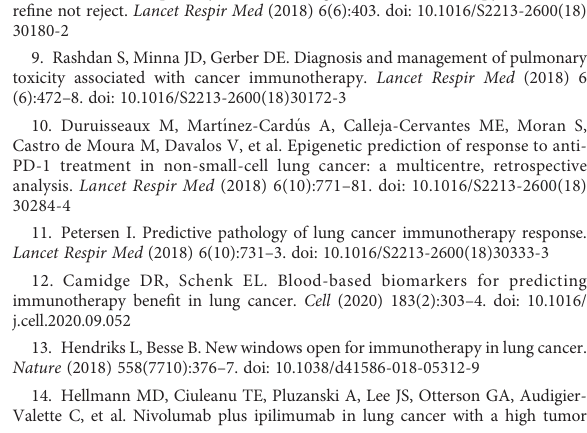
of TAM subgroups. (D) C1QA. (E) C1QB. (F) APOE. (G) C1QC. (H) Analysis of TAM clusters. (I) Subtypes derived from re-clustering of TAM cell populations. SUPPLEMENTARY FIGURE 4 Screening of differentially expressed genes amongst tumor macrophage subsets. (A) Dotplot of Top5 maker genes of each subtype. Abscissa axis: marker genes. Ordinate axis: top5 of TAM subtypes. Colors: mean expression per-group; Dot sizes represent the fraction of cells in each group (%). (B – G) Violin plots of the expression of the top5 marker genes. Abscissa axis: different TAM subtypes. Ordinate axis: gene expression. SUPPLEMENTARY FIGURE 5 Pseudo-chronological analysis of tumor macrophages for simulation of the dynamic changes of macrophages. (A – C) Differential statesaccording to monocle trajectory analysis, distribution of TAMs in trajectories, and pseudo-sequences ofdifferentiation. (D) Genesin fl uencingdifferentiation states in the clusters. Left column: differentclusters. Right column: names of genes. (E) Pathway enrichment analysis of different TAM subtypes. Color: correlation; Red: positive correlation; Blue: negative correlation. Numerical values: correlation p-value. SUPPLEMENTARY FIGURE 6 Comparison of risk scores corresponding to the clinical characteristics of the different groups. (A) Age, (B) Gender, (C) Radiation therapy. (E) Pathologic T cells; (E) Tumor stage. Abscissa axis: Different groups. Ordinate axis: risk scores. (F) Nomogram model for risk scores and clinical factors according to the clinical characteristics of prognosis. (G) Calibration curve for 1-year survival. (H) . 2-year survival. (I) 3-year survival. (J) 5-yearsurvival. Abscissaaxis: predicted probability ofsurvival. Ordinate axis: actual survival. SUPPLEMENTARY FIGURE 7 Assessment of immunotherapy prognosis according to the risk score. (A) Survival analysis of immunotherapy responses in the training set. Abscissa axis: survival time. Ordinate axis: survival probability. Colors represent different risk groups. (B) Comparative analysis of the proportion of treatment response states between high and low risk groups. (C) Comparative analysis of risk scores for different treatment response